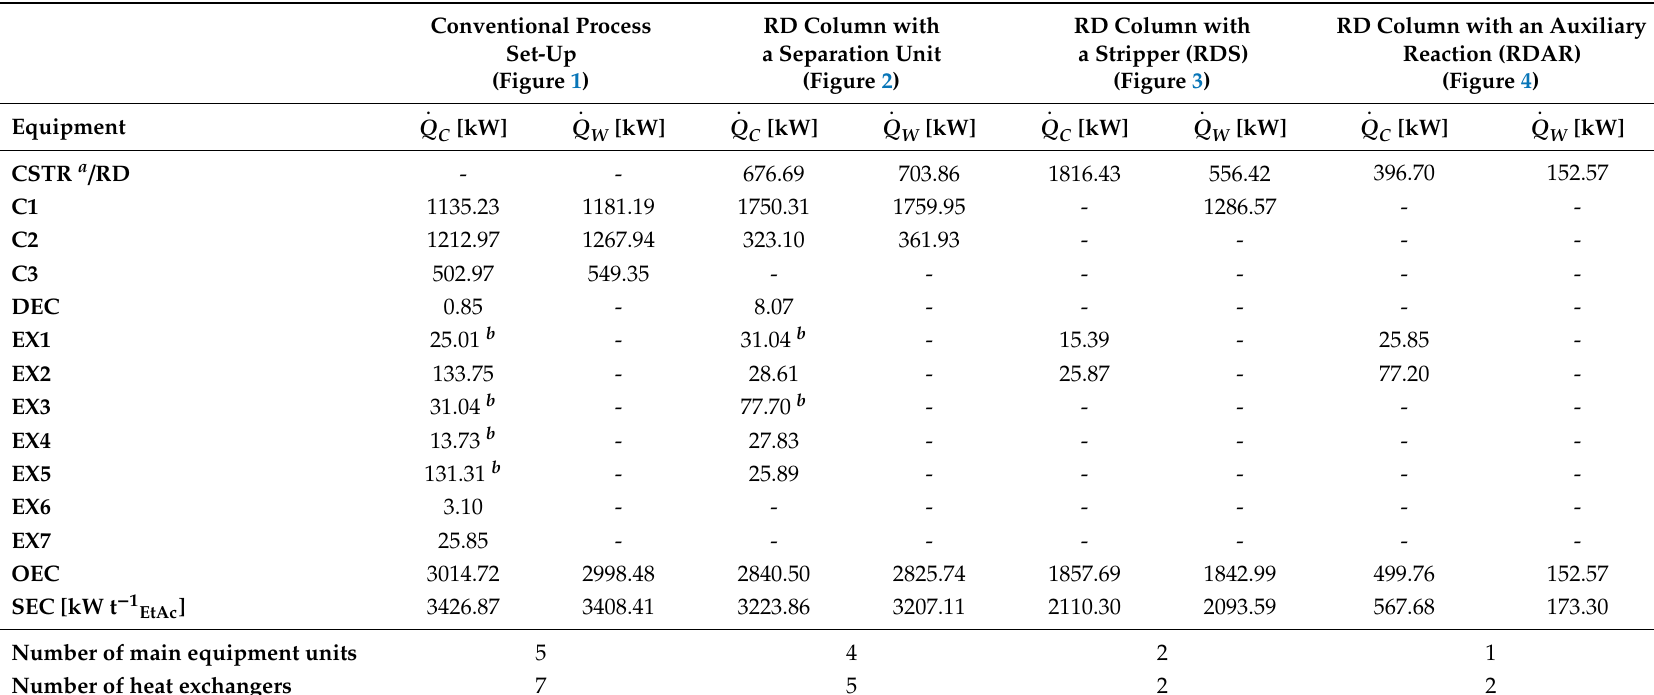
Table 9. Energy requirements and the number of the equipment for designed ethyl acetate production